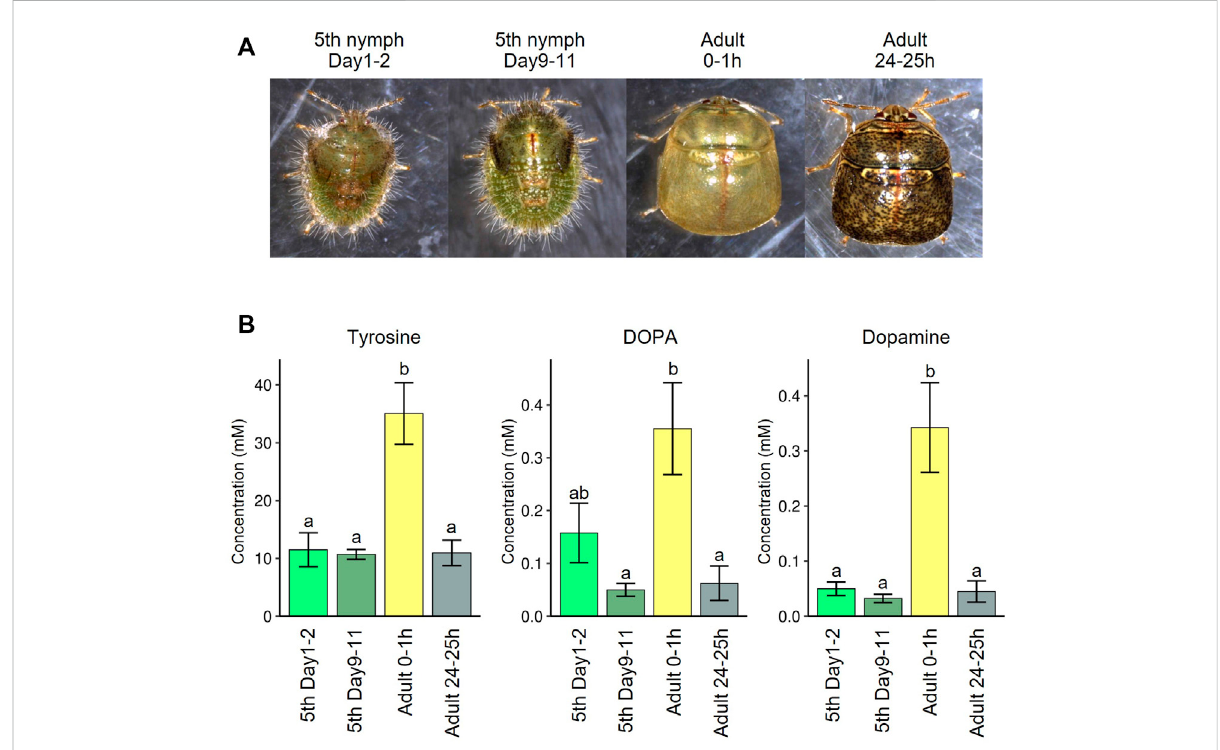
FIGURE 7 Tyrosine recruitment during cuticle pigmentation upon adult emergence of M. punctatissima . (A) Photos of fi fth instar nymphs and adults before and after adult molting. (B) Hemolymph titers of tyrosine and its derivatives, DOPA and dopamine, before and after adult molting. To liberate from their conjugated forms (Hopkins etal., 1998), thehemolymph samples were treated with 6 N hydrogen chloridesolution at 105 ° C for 24 h.The graphs show mean ± s.e.m. ( N = 4). Different letters (a,b) indicate statistically signi fi cant differences ( p < 0.05, likelihood ratio test for GLM and posthoc multiple